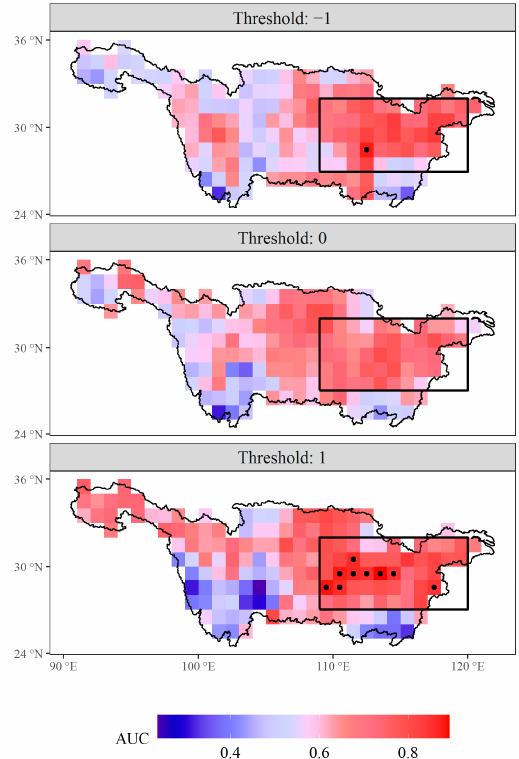
Figure 4. AUC for each grid of rainfall over the Yangtze River Valley based on WPSHI(R) as the indicator. Grids with AUC larger than 0.85 are labelled as black points. The box region (27°–32° N, 109°–120° E) shown in the figure is used to calculate the Yangtze River Summer Rainfall Index (YRSRI).